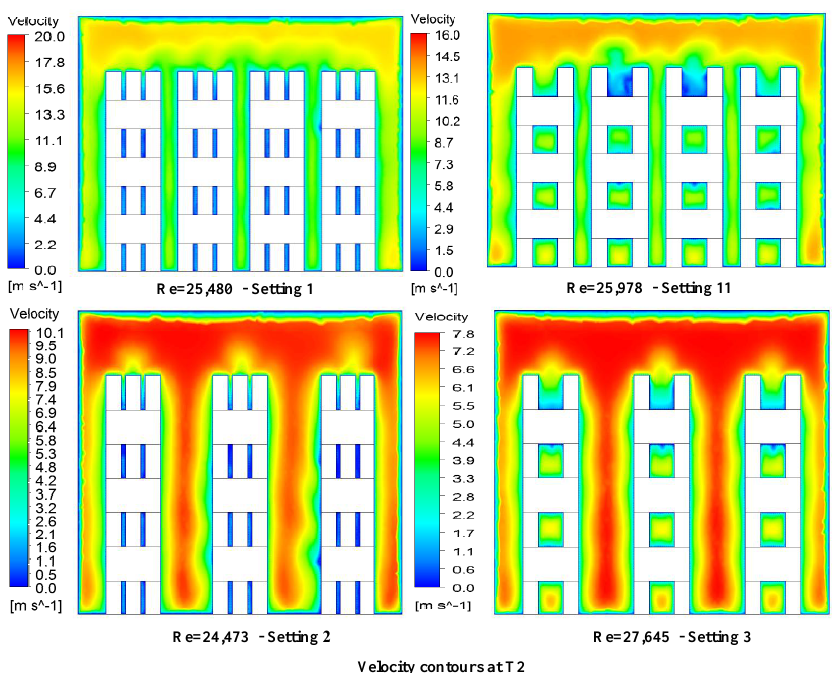
Figure 16. Velocity contours in a transversal channel between bricks in the fifth row. Figure 17 shows the variation of velocity contours in transversal planes before (at T1) and after (at T4) the fifth row for settings 11 and 3. A secondary flow is observed in setting 3, and the flow velocity increases in the gap between bricks compared to setting 11. The secondary flow is induced due to the flow separation through the column bricks. Configuration 11 produces the wake zone with the slowest secondary flow velocity. By directing the main flow through the bricks to the wake zone, the wake size may be decreased, and the heat transfer rate may increase.